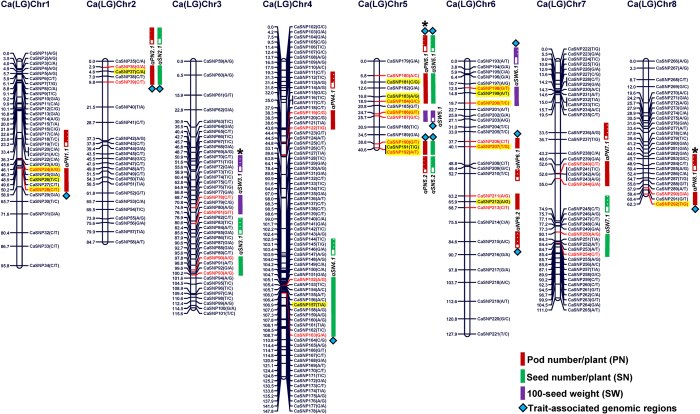
Fifteen major genomic regions harbouring 18 significant QTLs (PVE 13.6-28.7%) associated with three seed and pod yield-contributing traits (PN, SN and SW) identified and mapped on eight LGs (with a significant LOD score of >5.1; p <0.05) using a 283 F4 mapping population (ICC 6013 x ICC 7346).The genetic distance (cM) and identity of the marker loci integrated on the LGs are indicated on the left and right side of the chromosomes, respectively. Eighteen major genomic loci underlying 13 robust QTLs showed strong association with PN, SN and SW traits based on GWAS are highlighted with yellow. Brown, green and violet lines indicate the QTLs regulating PN, SN and SW mapped on eight LGs, respectively. The directions of QTLs (additive effects) are designated with filled (ICC 6013-specific alleles) vs. empty (ICC 7346-specific alleles) boxes. qPN1.1 (QTL for pod number on chromosome 1 number 1), qSN2.1 (QTL for seed number on chromosome 2 number 1) and qSW3.1 (QTL for seed weight on chromosome 3 number 1). *qPN5.1, qPN8.1 and qSW3.1 correspond to known QTLs (TA103, TS45 and TA53 SSR markers flanking/linked to QTLs) from early reports by Radhika et al.13; Gowda et al.18; Varshney et al.30.